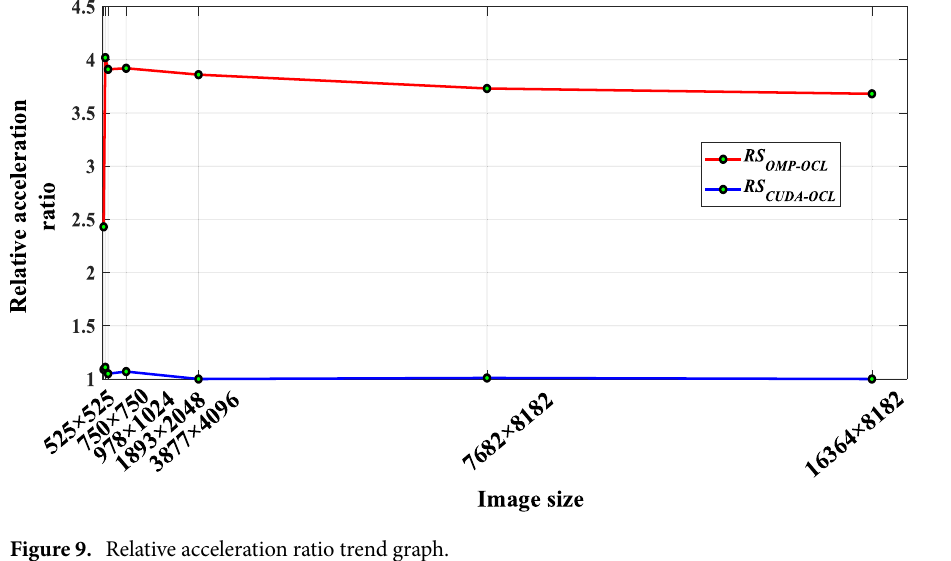
Figure 9. Relative acceleration ratio trend